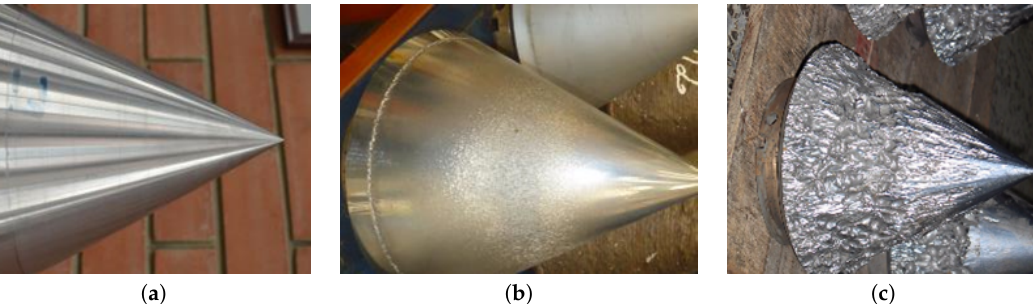
Figure 3. Needle valve wear status. ( a ) 0 h operation; ( b ) 9000 h operation with low sediment load; and ( c ) 1 h operation with high sediment load. Reported by the authors in